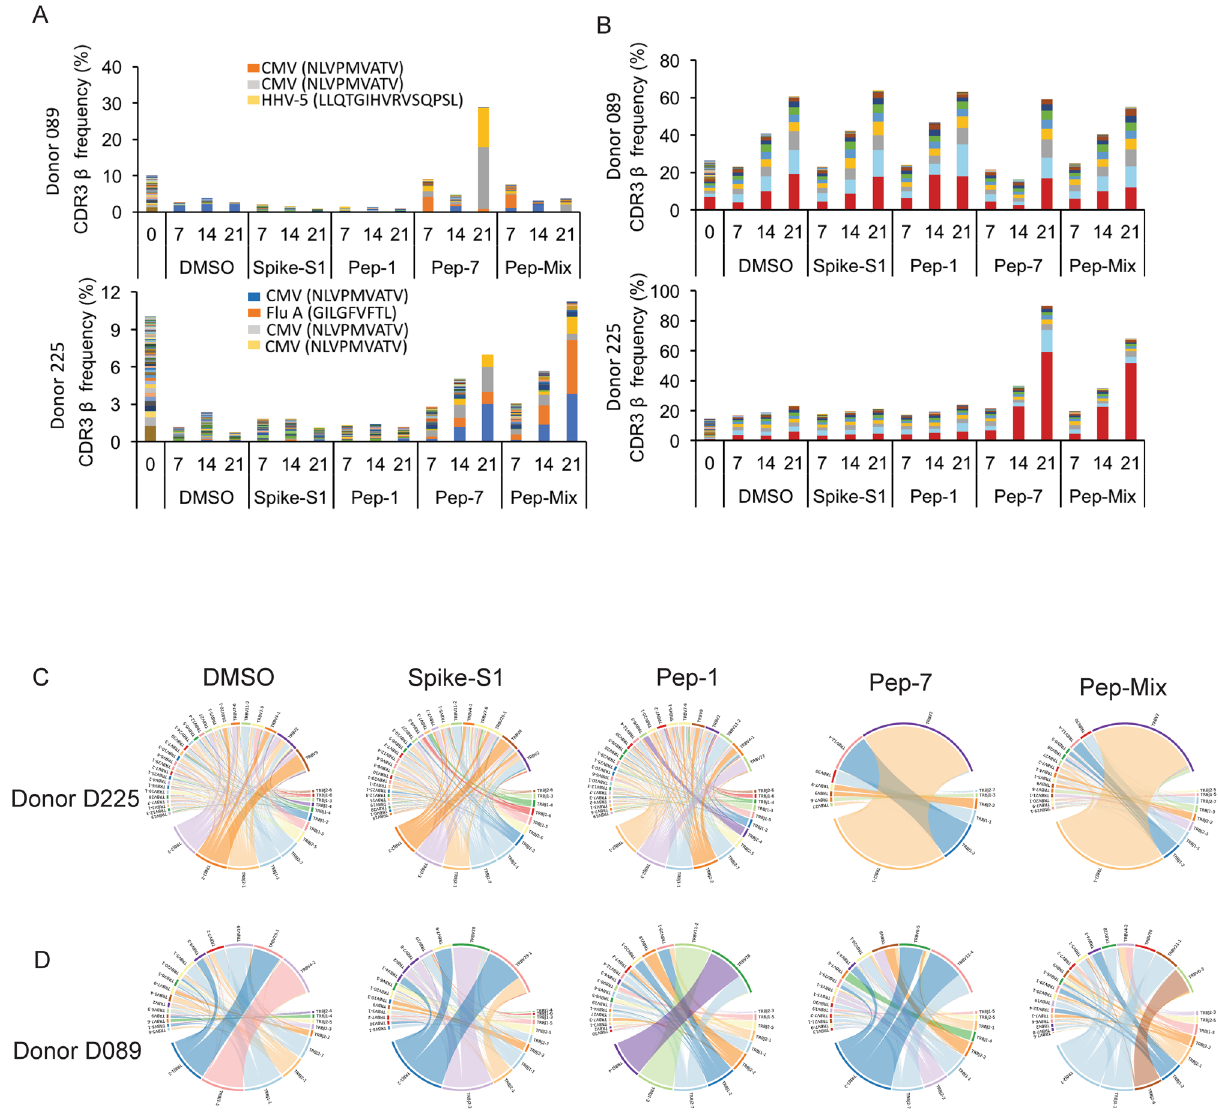
Figure 3. Bulk TCR repertoire analysis after in unexposed donors following in vitro stimulation of PBMCs at different time points with the indicated peptides. ( A ) Expanded public CDR3-βs recognizing shared antigens in the D089 (upper panel) and D225 (lower panel). ( B ) Expanded private CDR3-βs in D089 (upper panel) and D225 (lower panel). ( C ) V–J gene usage in D225. ( D ) V–J gene usage in Table S3). Our assay method is enriched for the growth and proliferation of T-cells causing depletion of other immune cell types present in PBMC in a 14-day culture. Three cell types, CD8, γ/δ, and NK-T were detected in all the samples. Compared to DMSO and Pep-7 in which the CD8 T-cell fraction was ~ 60%, in spike-S1 and spike-S2 the CD8 T-cell fraction was 50% and 38% respectively. Conversely, the CD4 cluster was expanded in spike-S1 (12%) and S2 (27%) compared to DMSO (7%) suggesting that the spike peptide pools engaged CD4 T-cells (Table S3). The single-cell transcriptomic analysis further revealed that Pep-7 induced effector phenotype in the CD8 T-cell cluster by the expression of activation markers IFN-γ, 4-1BB (Fig. 4B) TNFRSF9, FAS, and TIGIT (Compare Figure S5D with S5A-C). The top 10 Pep-7-expanded clonotypes were CD27 + /SELL - suggest- ing transition towards effector memory phenotype (Fig. 4B). Spike-S1 and S2 peptides induced CD27 + /SELL - T-cells in the CD4 clones 6 and 4 respectively (Fig. 4B). Single-cell data revealed amplification of TRBV2 (40%) and TRBJ2-1 (32%) in Pep-7 stimulated T-cells (Fig. 4D) confirming the results from the bulk TCR analysis (Fig. 3C,D). Next, we mapped CDR3-β to specific clones from each treatment (Fig. 4C). The DMSO, spike-S1, and S2-treated samples shared many clonotypes among themselves in the same frequency range suggesting weak antigen-induced activation and proliferation of T-cells. However, Pep-7 treated sample was enriched in many CDR3-β clones absent in other samples indicating the specificity of response (Fig. 4C, red bars). Four clones among the top-20 clones encoded CMV and flu-specific CDR3-βs in Pep-7 treated sample but not in other